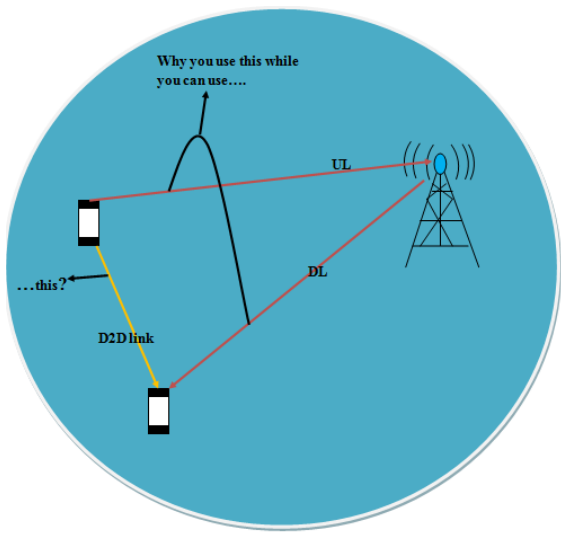
Figure 4. D2D communication in cellular network.